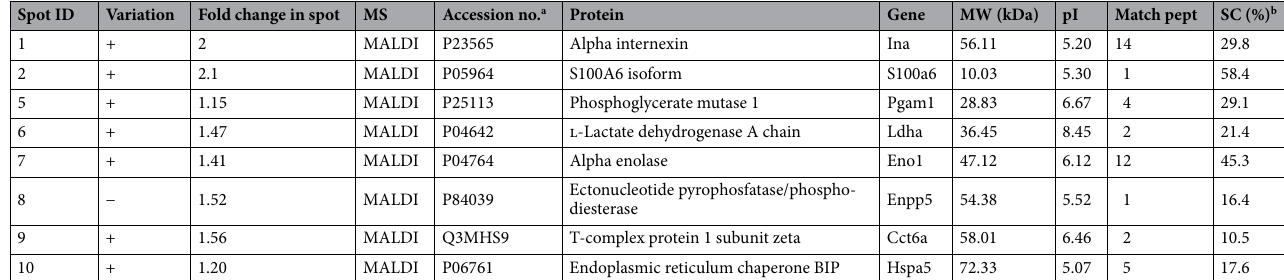
Table 1. Proteins identified by mass spectrometry. a Accession number according to the swiss-prot Rattus novergicus database. b SC % = % of the sequence identified.